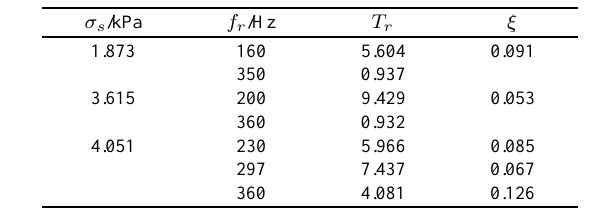
Table 2 Vibration transmissibility of honeycomb paperboard ( T = 20 mm)